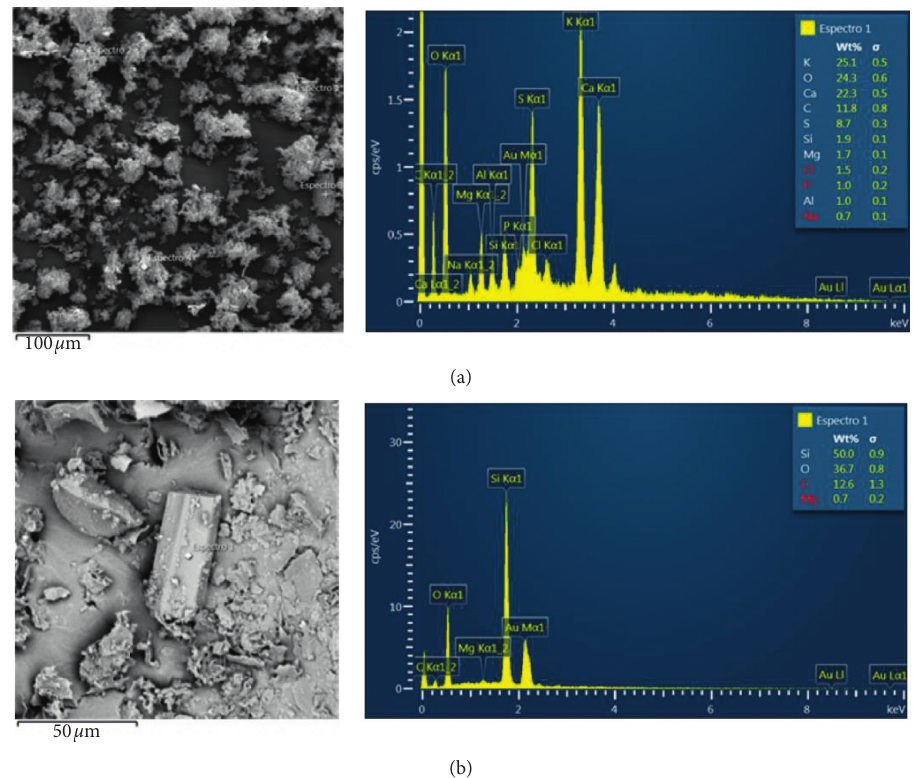
Figure 4: Scanning electron microscopy-EDS detector of (a) SCBA-A and (b)